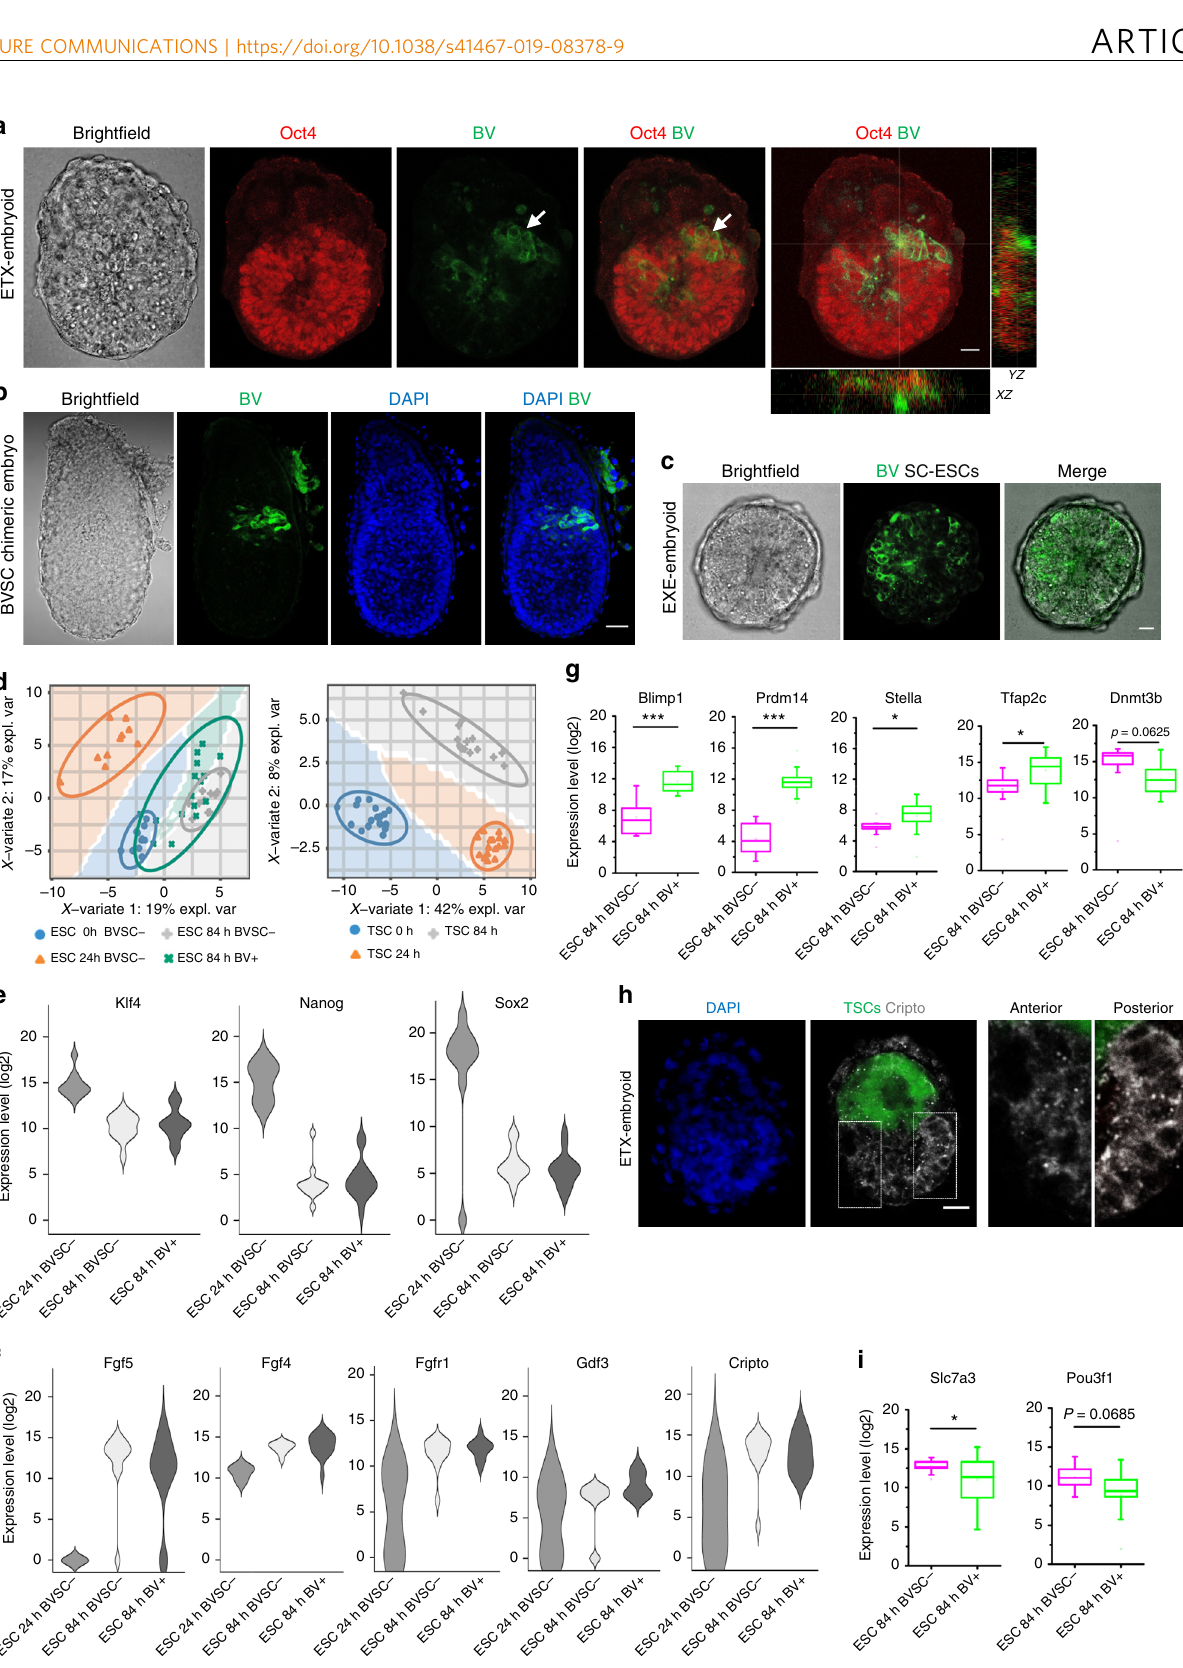
mouse embryos initiate gastrulation, asymmetric patterns of